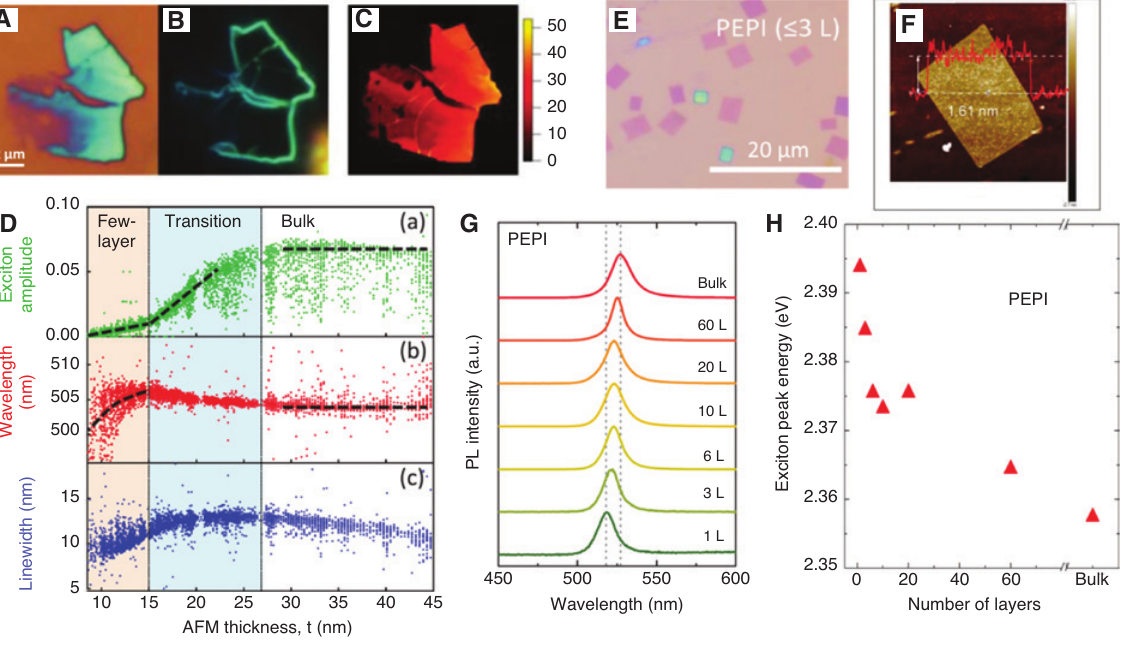
Figure 5: Optical properties of PVKs: the role of the crystal thickness. Optical microscope images in (A) bright and (B) dark field on an exfoliated phenethylammonium lead iodide PVK. (C) AFM image of the same area; fitted exciton. (D) Amplitude, wavelength, and linewidth from reflectivity spectra taken from Ref. [64]. (E) Optical and AFM (F) images of thin phenethylammonium lead iodide PVK nanosheets; thickness-dependent PL spectra (G) and exciton peak energy (H) taken from Ref.